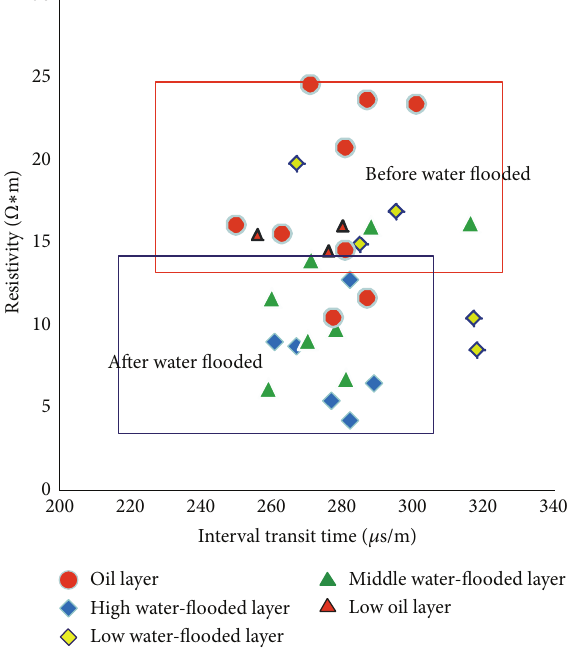
Figure 9: The relationship between interval transit times and resis- tivity before and after water injection.